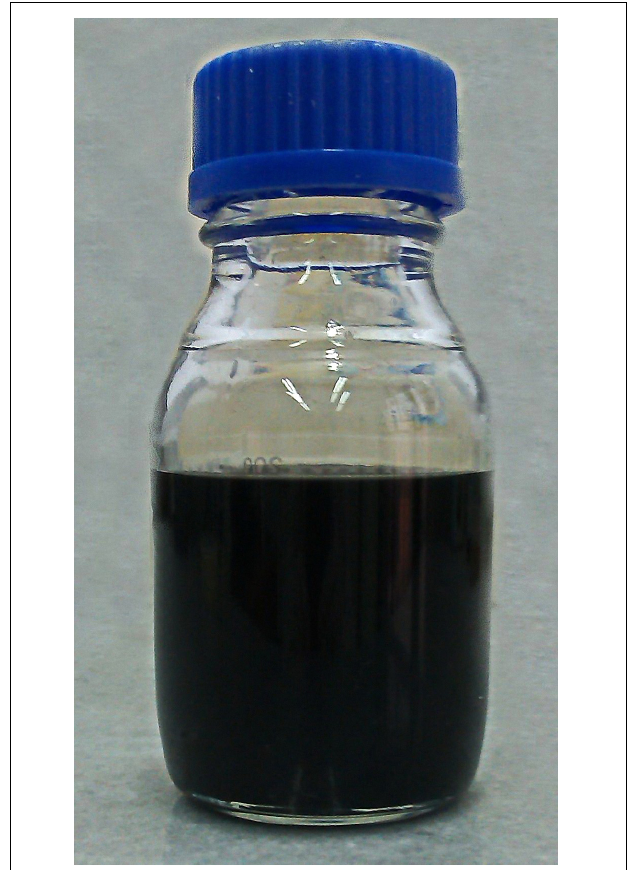
FIGURE 1 | An optical image of the composite solution after sonication and mechanical